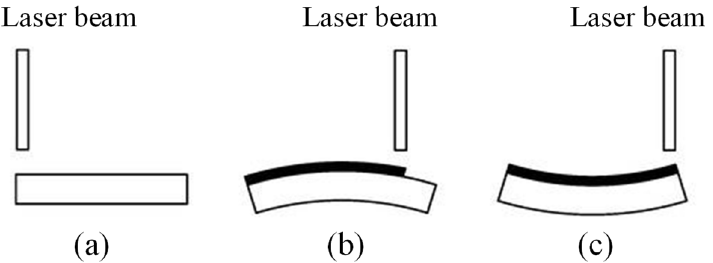
Figure 10. Schematic of the deformation process of thin-walled parts. ( a ) Before the LAM; ( b ) During the LAM; ( c ) After the LAM (Reprinted from ref. [46]. copyright (2020), with permission from MDPI).